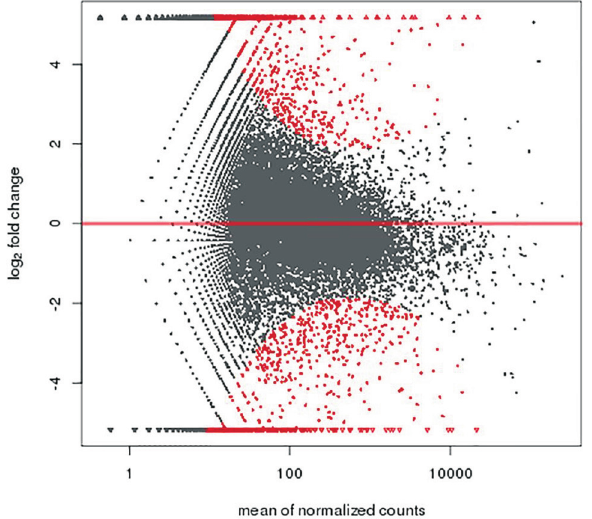
Figure 5 - A total of 1,527 genes were differentially expressed between the co-blocking group and MR1 group, among which 230 genes were up-regulated and 1,297 down-regulated. Abscissa: mean of normalized counts; Ordinate: log 2 fold